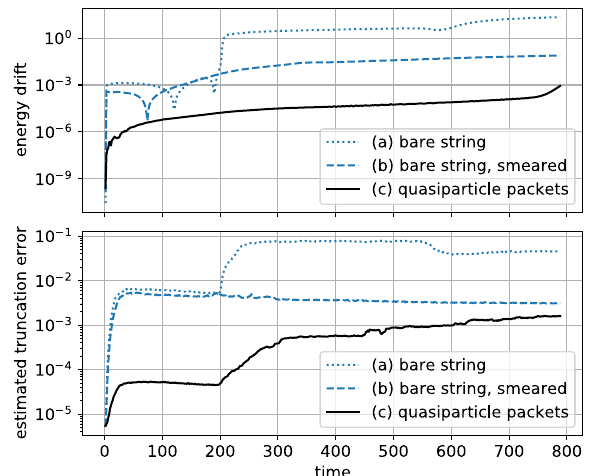
FIG. 23. Evolution of the energy expectation value and MPS truncation error for the simulations of Fig. 22. Energy drift [ | 1 − E ( t )/ E ( 0 ) | ] indicates deviation from unitary evolution and results from restriction to a maximum bond dimension of 64 as well as from numerical integration errors (RK4 step size of approximately 0.08). Truncation error (estimated as the maxi- mum over cuts of the smallest Schmidt coefficient) results from the limited bond dimension and increases as entanglement is produced.